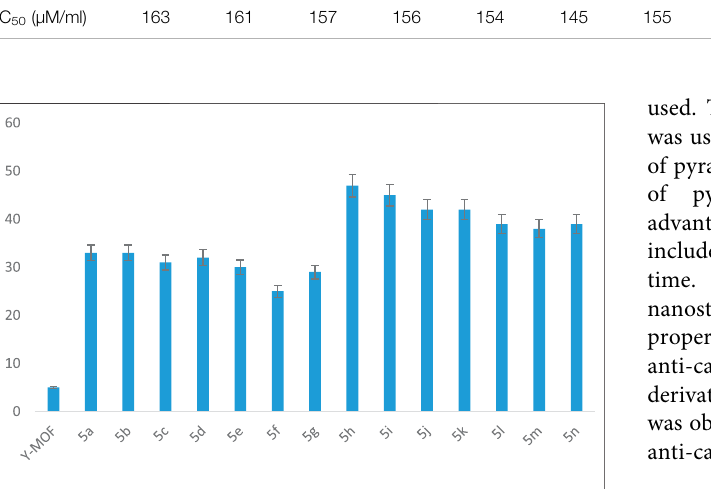
FIGURE 11 | Cell proliferation and viability of Y-MOF and pyrazolopyranopyrimidine derivatives in concentrations of 300 μ M/ml. Data represent mean ( n = 3) ±